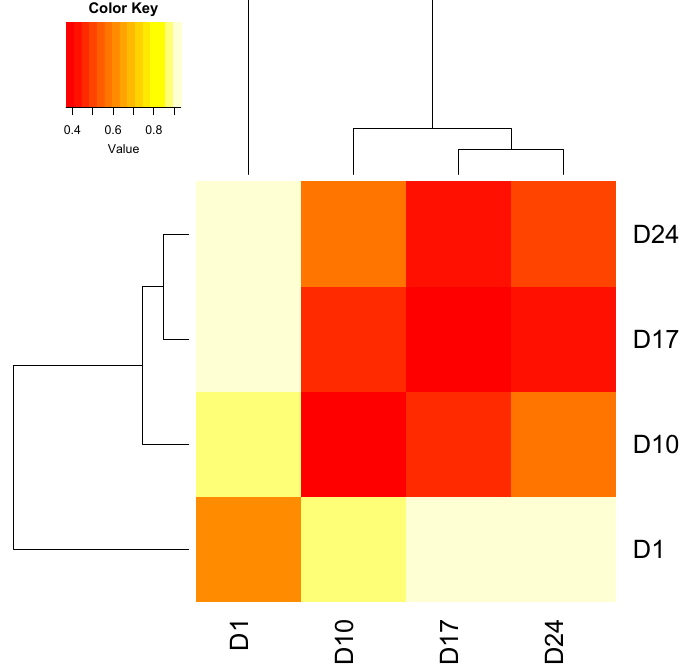
Figure 5. Heatmap of mean Bray-Curtis distance between time-points from stormwater inoculated columns. Colors indicate mean distances between biological replicates (diagonal) or all sample comparisons between different time-points, with red indicating more similar and yellow indicating more different. The last two time-points are as similar between time-points as within time-points, suggesting that the community is stabilizing. Labels indicate Day (D) in experiment 1, 10, 17, and 24.